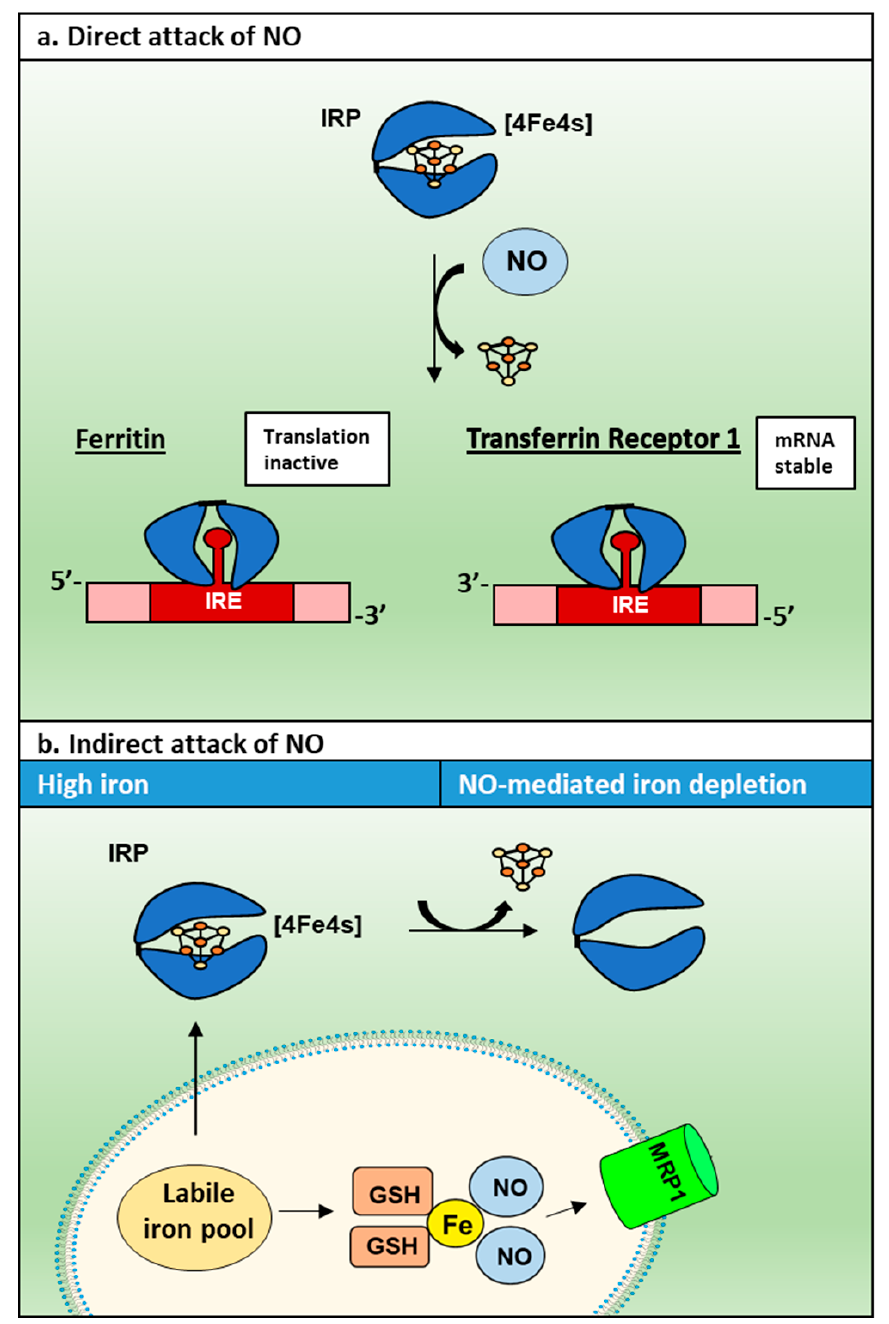
Figure 5. The direct and indirect impact of NO on IRP1 and IRE-binding. In the presence of NO, two mechanisms result in the loss of the [4Fe-4S] cluster: ( a ) direct attack of NO inducing disassembly of the cluster; and ( b ) an indirect mechanism where NO binds intracellular iron to induce its release from cells, resulting in iron depletion that therefore prevents [4Fe-4S] cluster biogenesis. Another important consequence of NO’s ability to bind intracellular iron is the up- regulation of N-myc downstream-regulated gene-1 (NDRG1), which suppresses tumor cell signaling and migration [117,118]. NDRG1 is a ubiquitous cellular protein that is tightly regulated by N-myc [119], histone acetylation [120], intracellular calcium [121,122], and cellular iron levels [123,124]. The up-regulation of NDRG1 is observed in neoplas- tic cells in response to iron chelators that induce its expression via HIF-1 α [124–126]. The activity of NDRG1 suppresses the oncogenic activity of a multitude of signaling